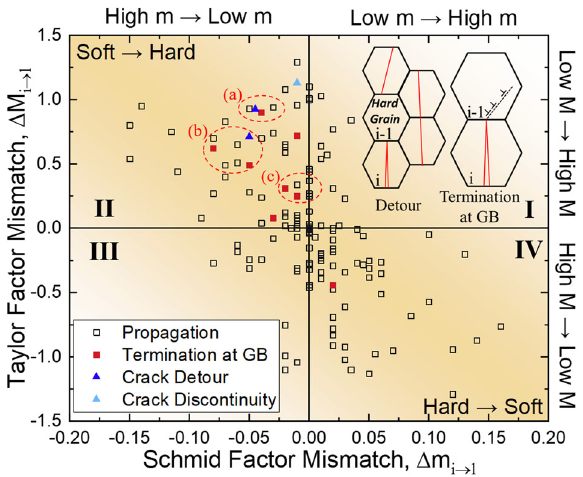
Fig. 8 Schmid-Taylor factor mismatch map for transgranular SCC propagation paths. Each data point represents a grain pair (i.e., GB- crack interaction) along the crack path; data are gathered from all 37 EBSD-analyzed cracks. Subgroups of data points encircled a – c are further analyzed in Fig.